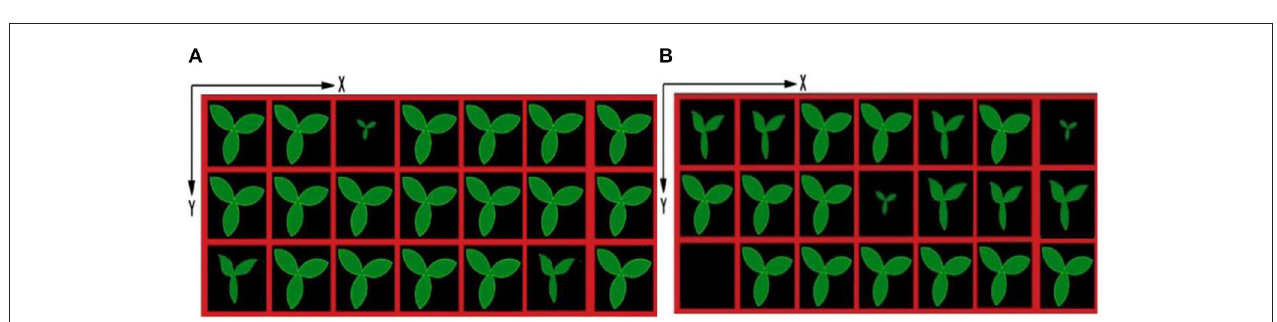
FIGURE 10 | Output ordinates based on the proposed method.